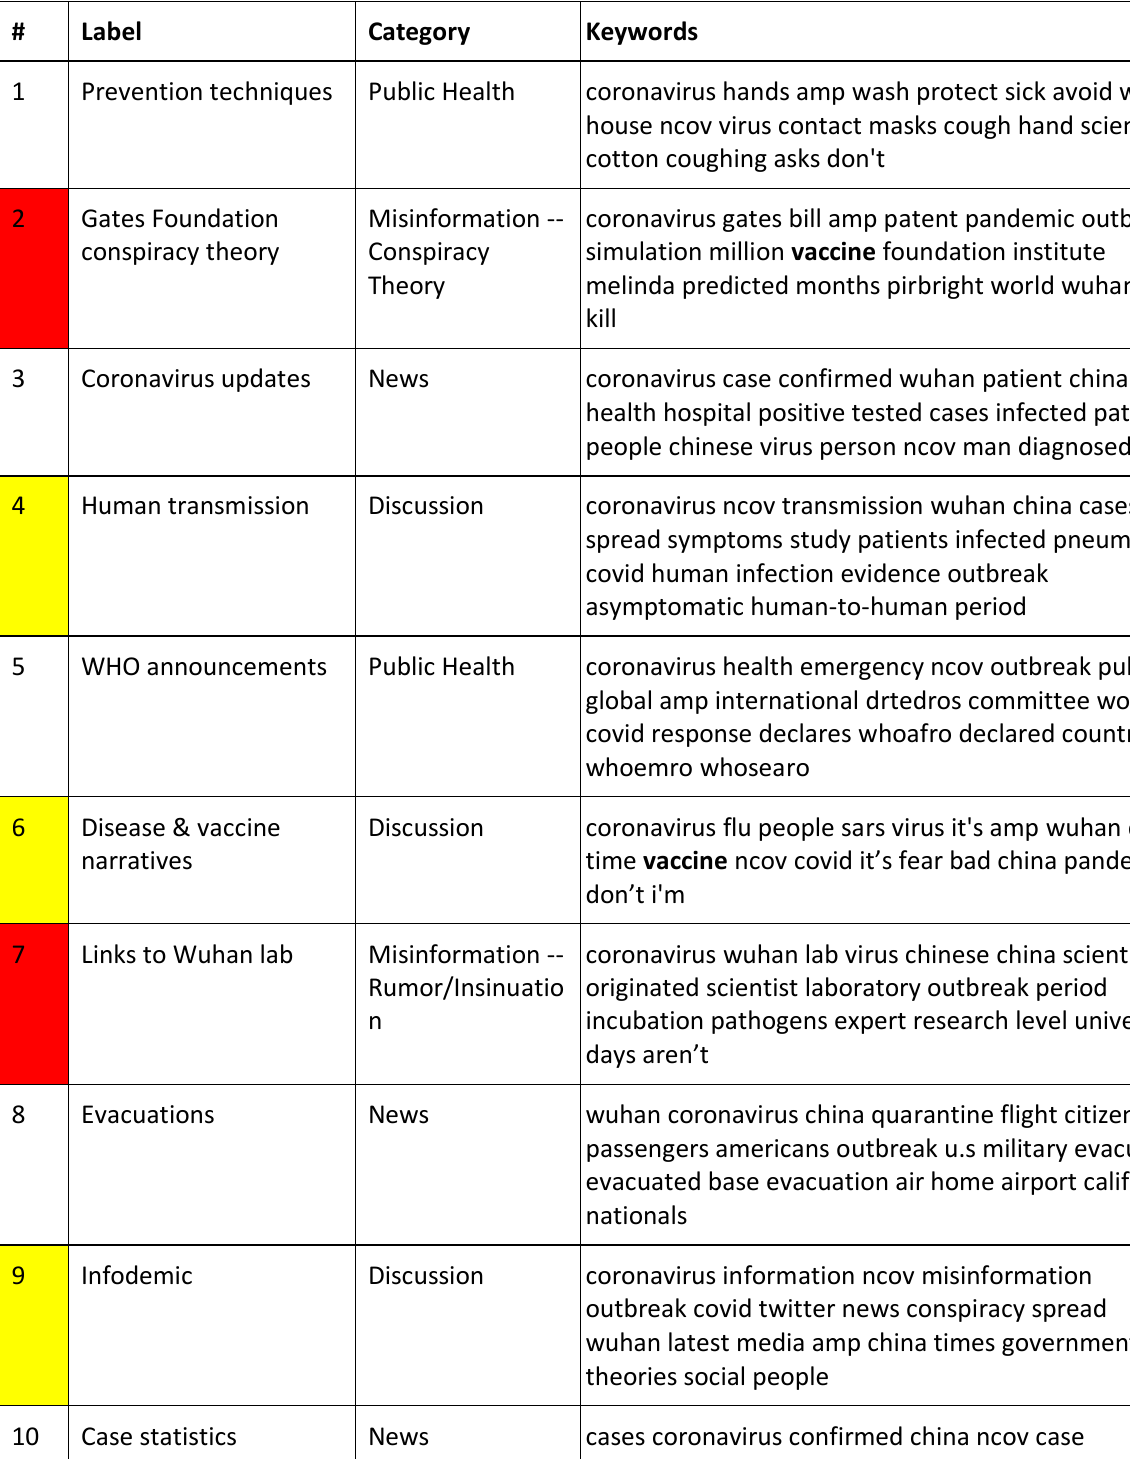
Table 5. Topics inferred using